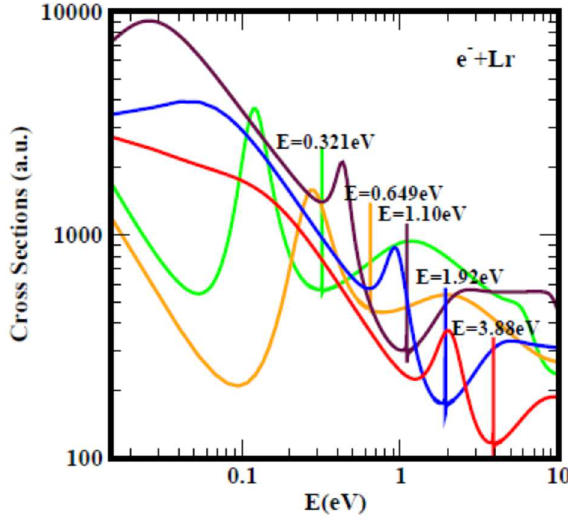
Figure 2. Total cross sections (a.u.) for the actinide atoms Fm (top panel) and Lr (bottom panel). In both panels the red curves represent the ground states. In Fm the blue and the orange curves and in Lr the blue and the brown curves are the metastable TCSs while the brown and the green curves in Fm and the orange and the green curves in Lr represent the excited state TCSs. The energy positions of the dramatically sharp lines correspond to electron BEs of the formed negative ions during colli- sions. The orange curve in the TCSs for Fm and the brown curve in those for Lr correspond to the polarization-induced TCSs with the deep R-T minima flipped over to SRs close to threshold (see also Figure 1 above).